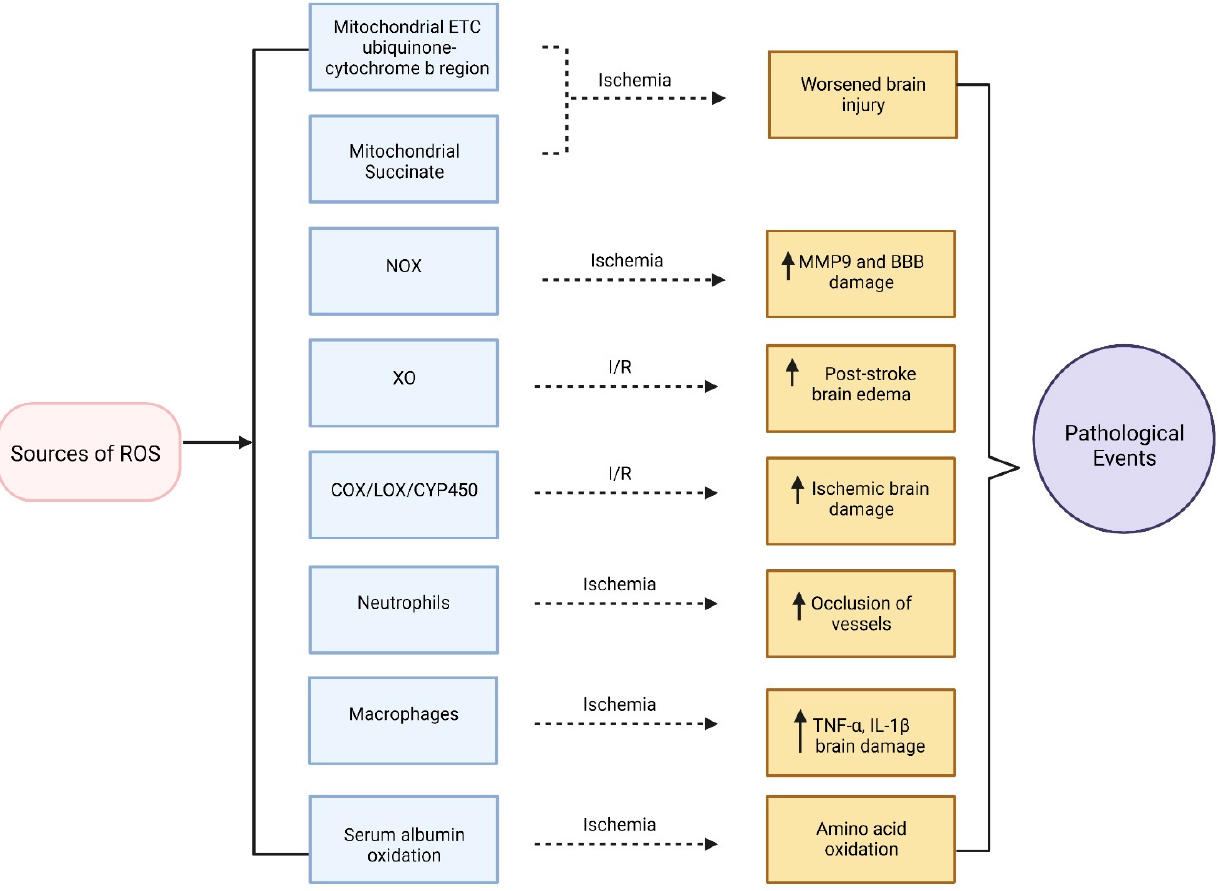
Figure 2. Sources of reactive oxygen species (ROS) and their perturbations in ischemic stroke.